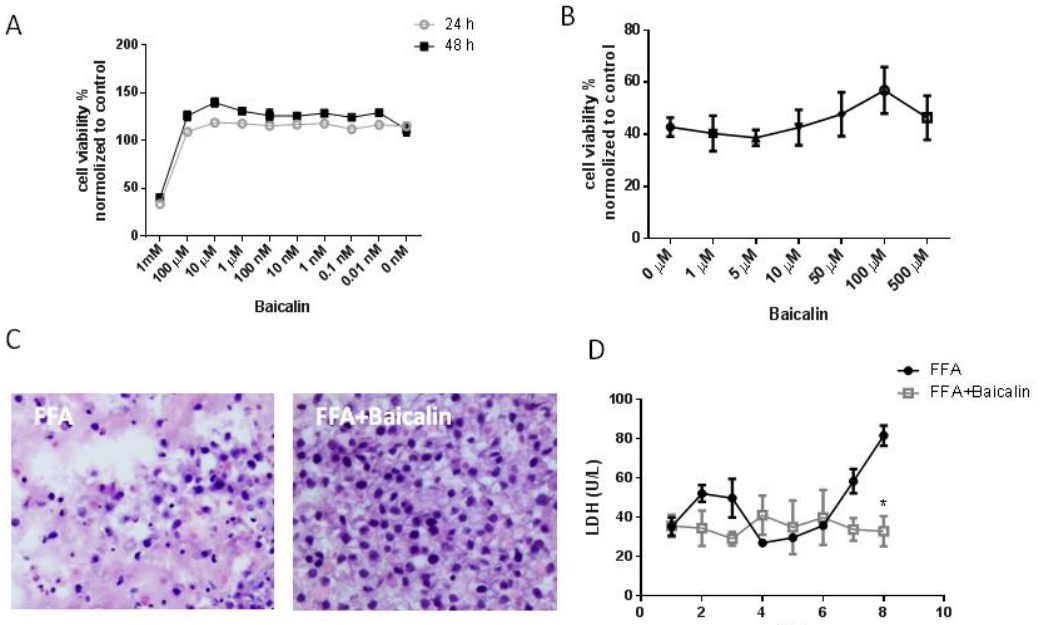
Figure 2. The protective effect of baicalin on hepatocytes cultured with fat-supplemented medium. ( A ) Cytotoxicity of baicalin in HepG2 cells treated for 24 h and 48 h (CCK8 assay, n = 6). ( B ) After cells were cultured with fat-supplemented medium, the effects of different concentrations of baicalin on cell viability were detected (CCK8 assay, n = 6). ( C ) H&E staining showed pathological changes in the FFA group with or without baicalin treatment (200 × ). ( D ) LDH levels in the supernatant of each group were measured every day ( n = 5). * p <